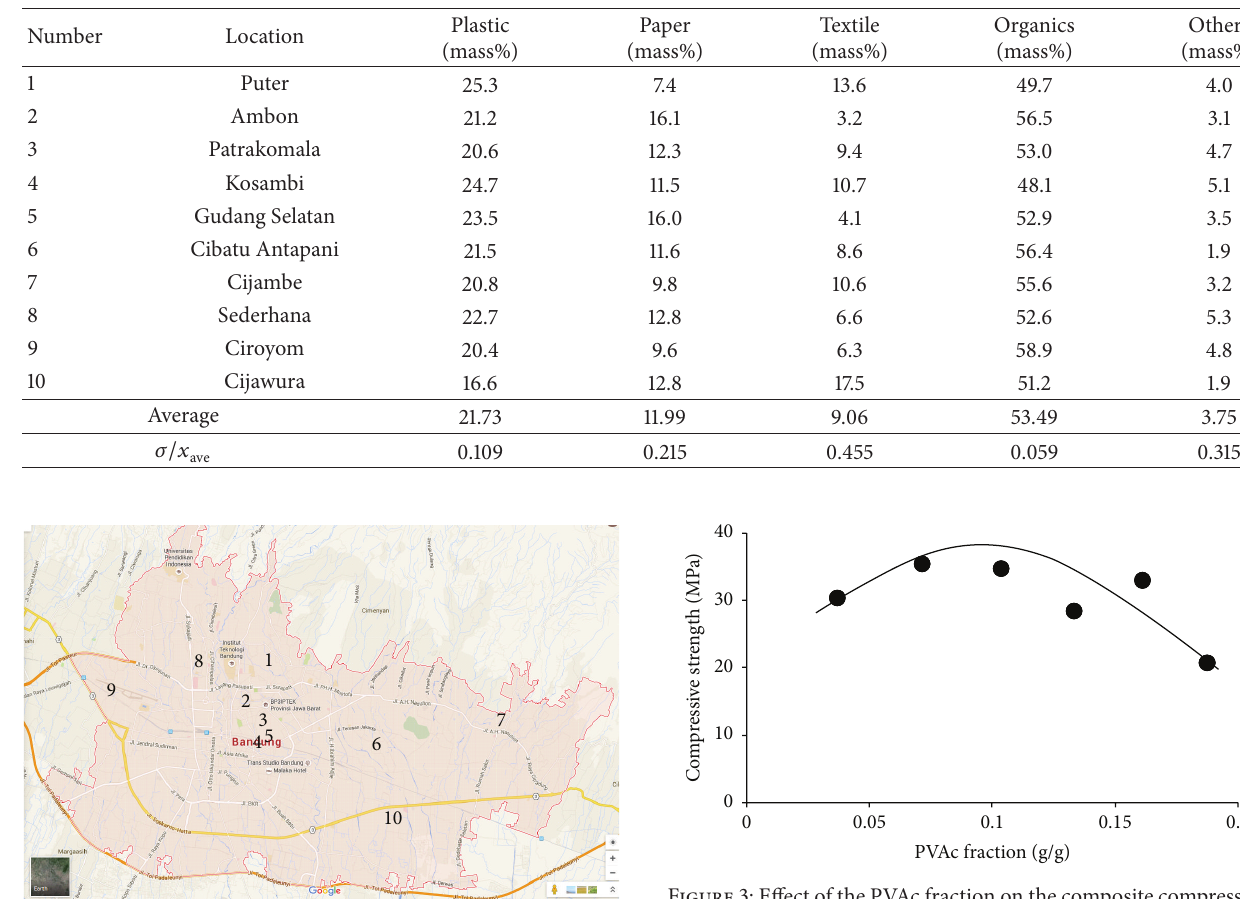
Table 1: Composition of the main components of waste at several landfills in Bandung.